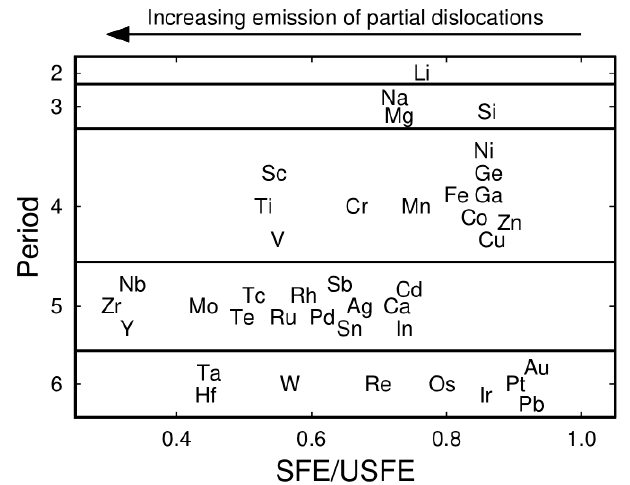
Figure 5. Stacking fault energy (SFE) to unstable stacking fault energy (USFE) ratio for analyzed aluminum alloys. The position of the analyzed alloy indicates SFE/USFE value.